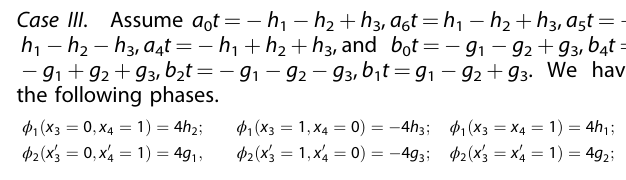
Fig. 4f, g and h respectively. Circuits for e (cid:2) iH 3 x 2 t are similar. Circuit for e (cid:2) iH 3 x t in each case is obtained by concatenating the corresponding circuits.